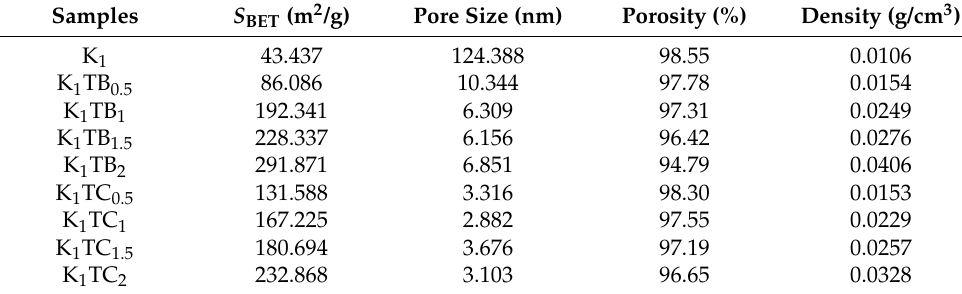
Table 1. Basic physical parameters of KTB and KTC aerogel samples.